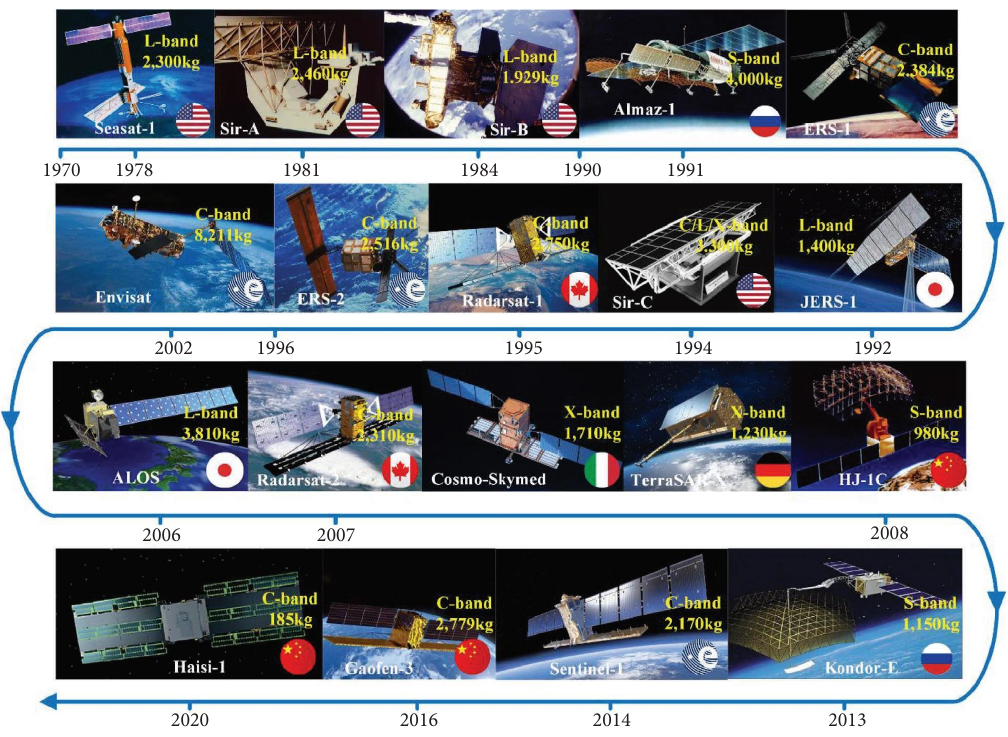
Figure 5: Typical SARs in